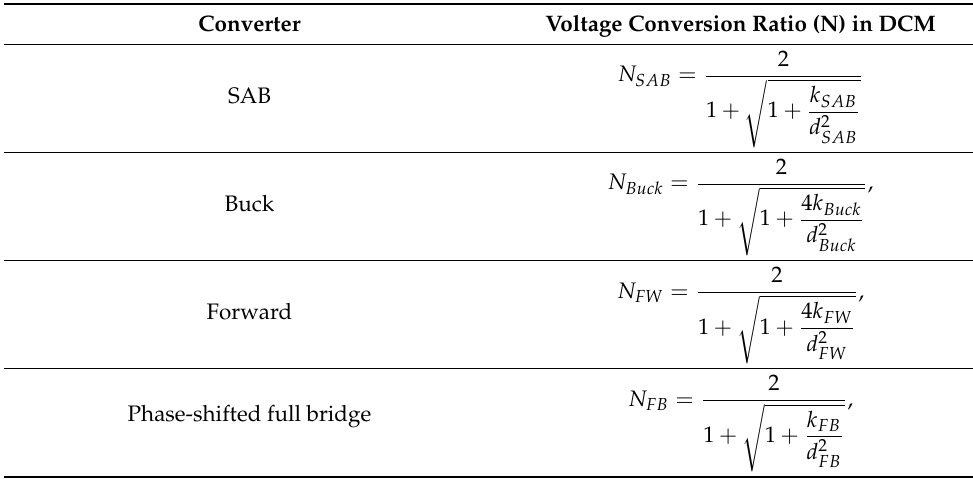
Table 1. Summary of the converter